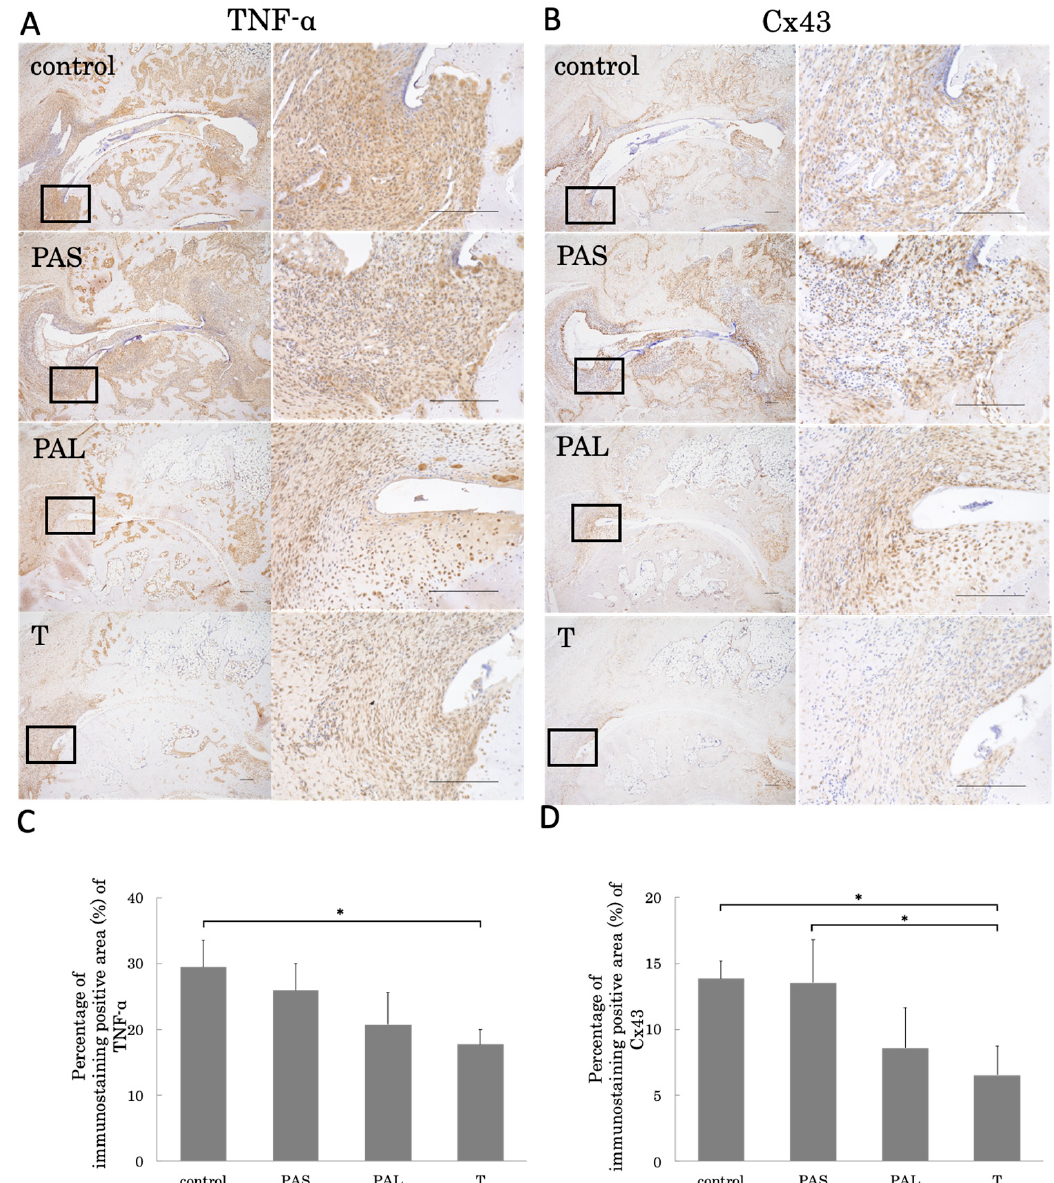
Figure 3. Representative micrographs of immunohistochemical staining for ( A ) TNF- α and ( B ) Cx43 are shown. All images were evaluated semi-quantitatively using ImageJ for ( C ) TNF- α and ( D ) Cx43. T group had significantly suppressed TNF- α and Cx43 expression. * p < 0.05. Scale bar = 200 µ m. The black spot represents the position in the high-magnification